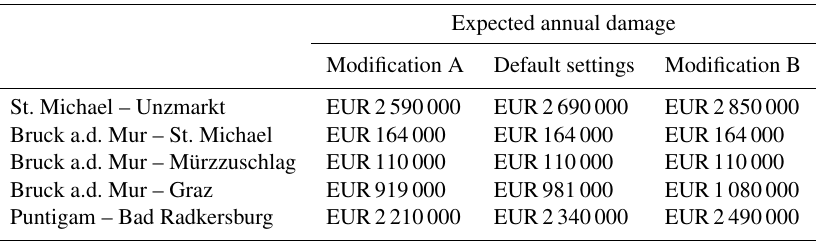
Table 3. Expected annual damage for different model settings. Modification variant A comprises of an assumed substructure height of 1.2m and a cost calibration factor of 0.2. Modification Variant B comprises of an assumed substructure height of 0.8m and a cost calibration factor of 0.3. All values are rounded to three significant digits.